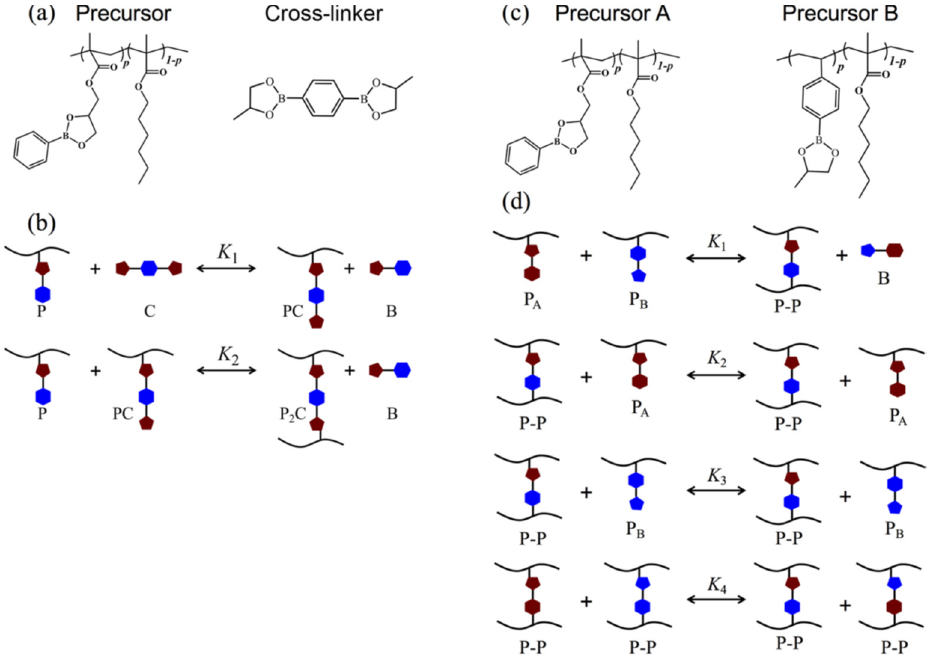
Figure 7. ( a ) Precursor and crosslinker structures and ( b ) two-stage reactions between them [110] and ( c ) structures of precursors A and B and ( d ) dominant reactions between them [109]. Reprinted with permission from [110]. Copyright (2021) American Chemical Society and [109]. Copyright